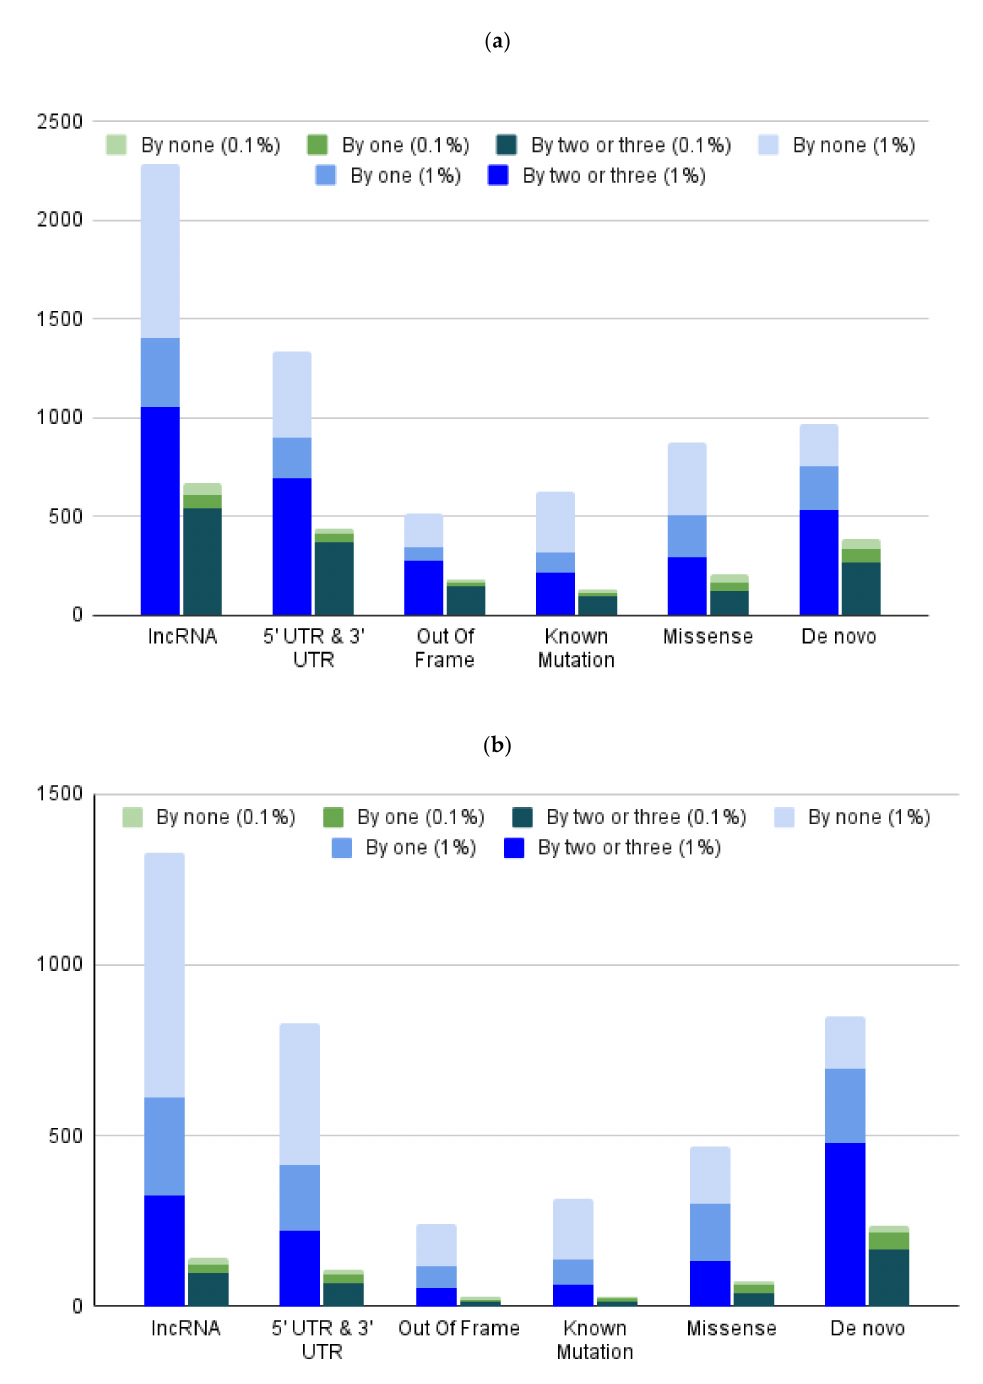
Figure 2. Software validation of non-canonical identifications by Bolt. ( a ) Count of Bolt’s non-canonical peptide identifications at 1% FDR for Mel15 data set that are also identified by at least two (dark blue) search engines: